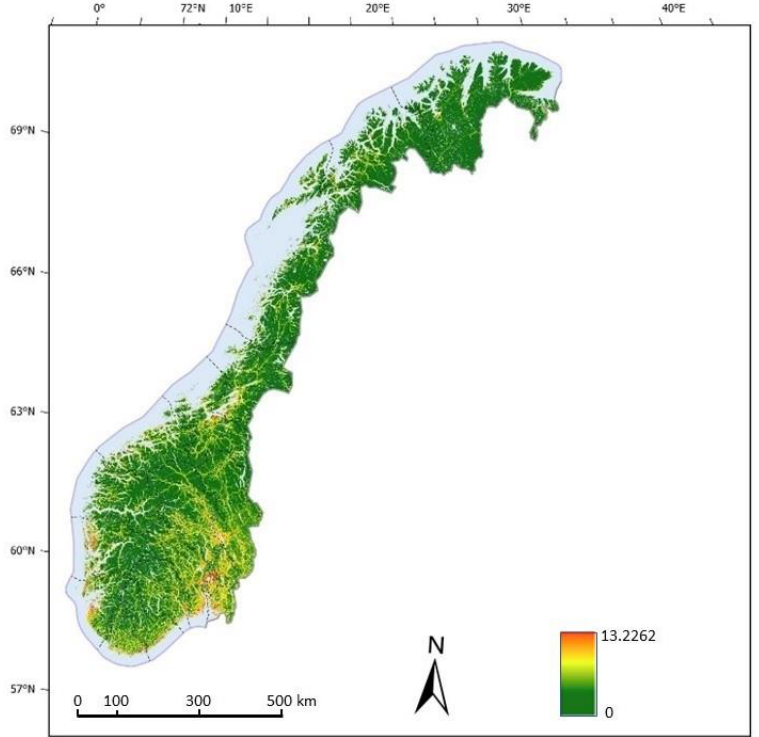
Figure 3. The human land use intensity across Norway, based on the calculation of the LUI index in a 100-m raster grid. Table 2. The frequency distribution of human land use intensity, as expressed by the LUI index, for major landscape-type areas in Norway (as given by the NiN landscape-type map for Norway; [36].